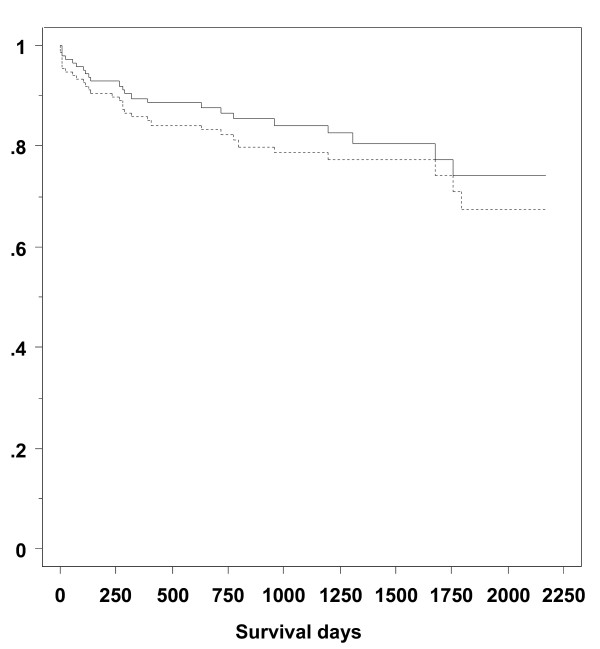
Kaplan Meier analysis of cumulative graft survival (dashed line) and cumulative patient's survival (full line). Graph shows results for 144 patients and 151 grafts.